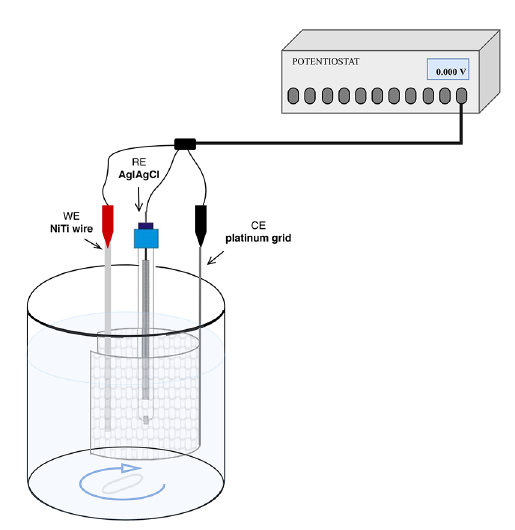
Figure 1. Schematic representation of the experimental setup for the electrodeposition using a three-electrode cell where the NiTi wire is connected as the working electrode (WE), a platinum grid is used as the counter electrode (CE), and an Ag|AgCl electrode is the reference electrode